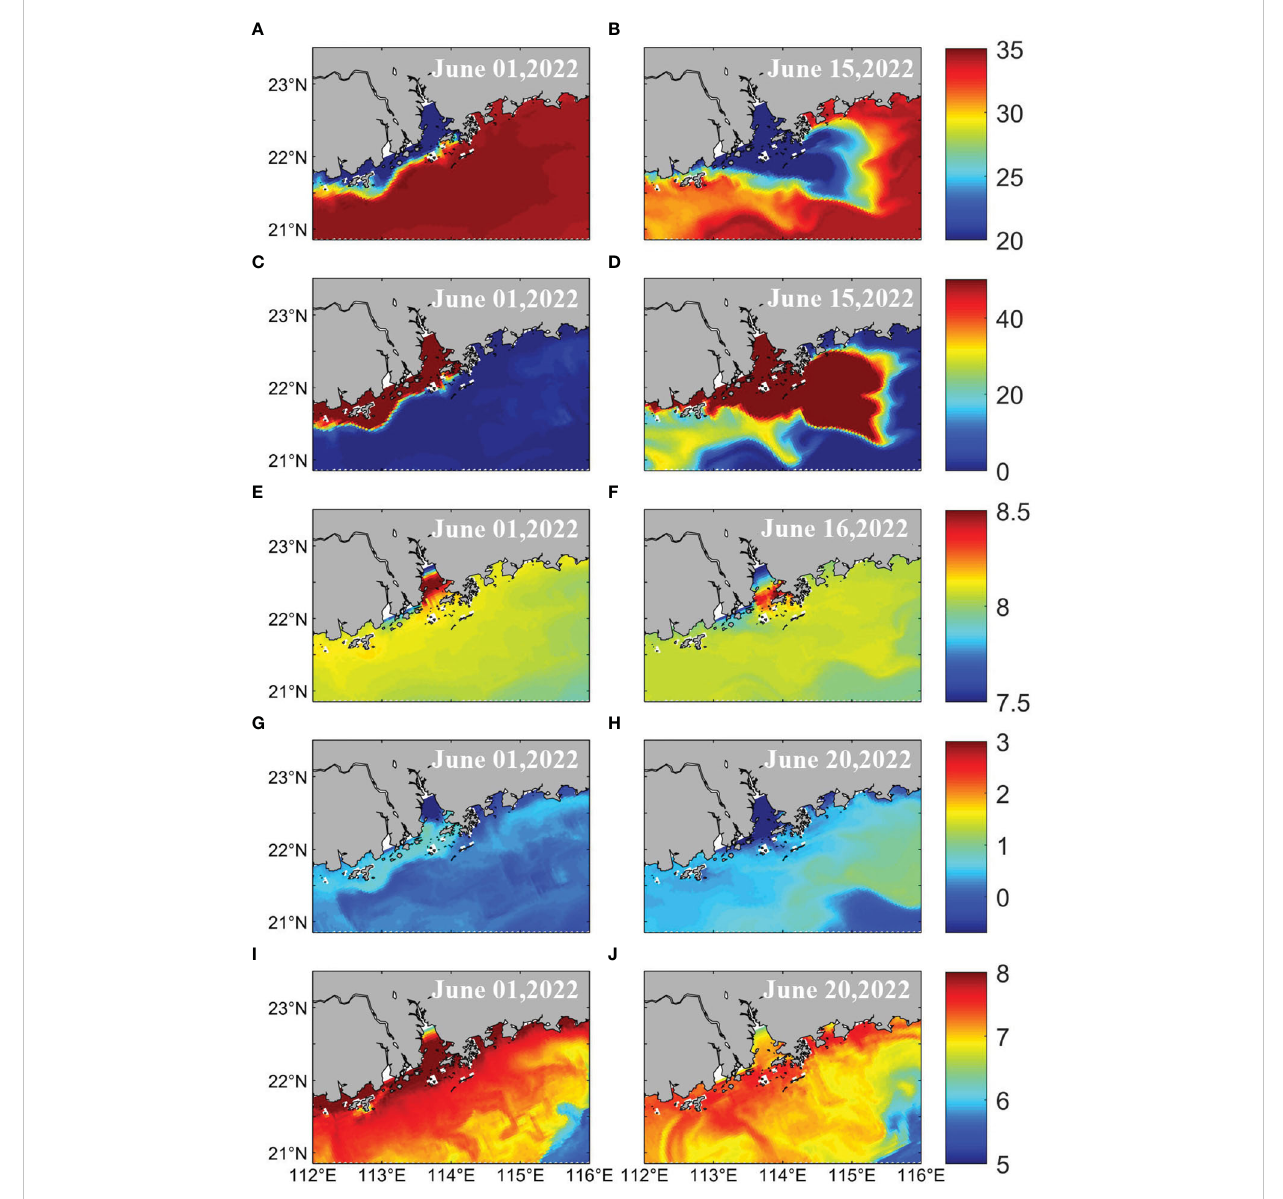
FIGURE 13 Comparison of SSS (A, B) , Sea Surface NO 3 (C, D) , pH (E, F) , Chlorophyll (G, H) , and bottom DO (I, J) before (June 01, 2022) and after fl ood occurrence (June 15, 2022). The snapshot dates are June 15, 2022 for surface salinity and NO 3 ; June 16, 2022 for surface pH; and June 20, 2022 for surface Chlorophyll and bottom